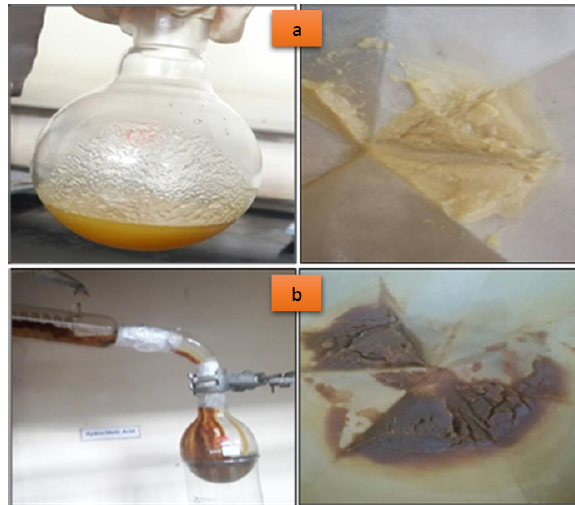
Fig. 3. The soap formation after catalytic pyrolysis of SPO using NiO-Malaysian dolomite catalyst at a) 400 ◦ C and b) 450 ◦